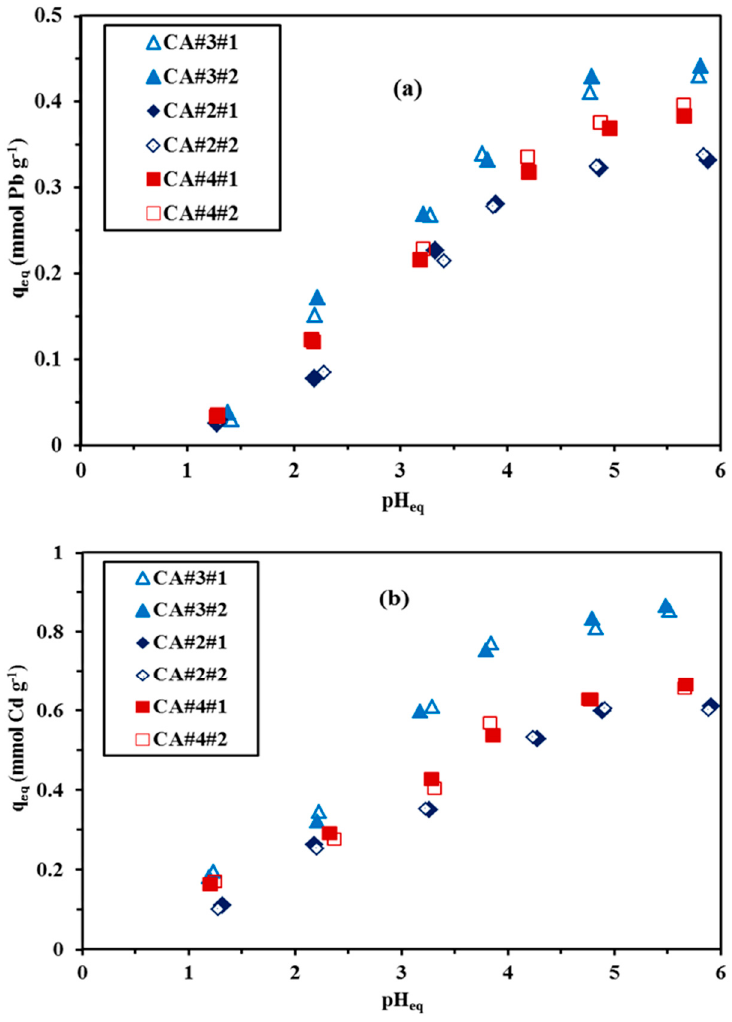
Figure 3. pH effect on Pb(II) ( a ) and Cd(II) ( b ) sorption using CA#2, CA#3 and CA#4 (C 0 : 0.958 mmol Cd L − 1 for 1st Series and 0.967 mmol Cd L − 1 for 2nd Series; C 0 : 0.48 mmol Pb L − 1 for1st Series and 0.51 mmol Pb L − 1 for 2nd Series; sorbent dosage, SD: 1 g L − 1 ; temperature, T: 23 (±3) °C; time: 48